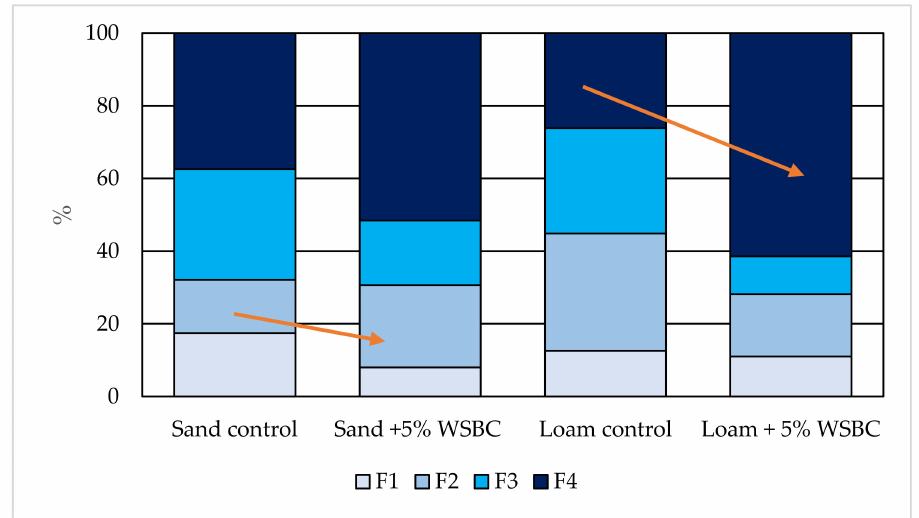
Figure 2. Cobalt speciation in treated and untreated soils. Cobalt fractions: F1, exchangeable and bound to carbonates; F2, reducible or bound to Fe and Mn-oxides; F3, oxidiziable or bound to organic substances; and F4,